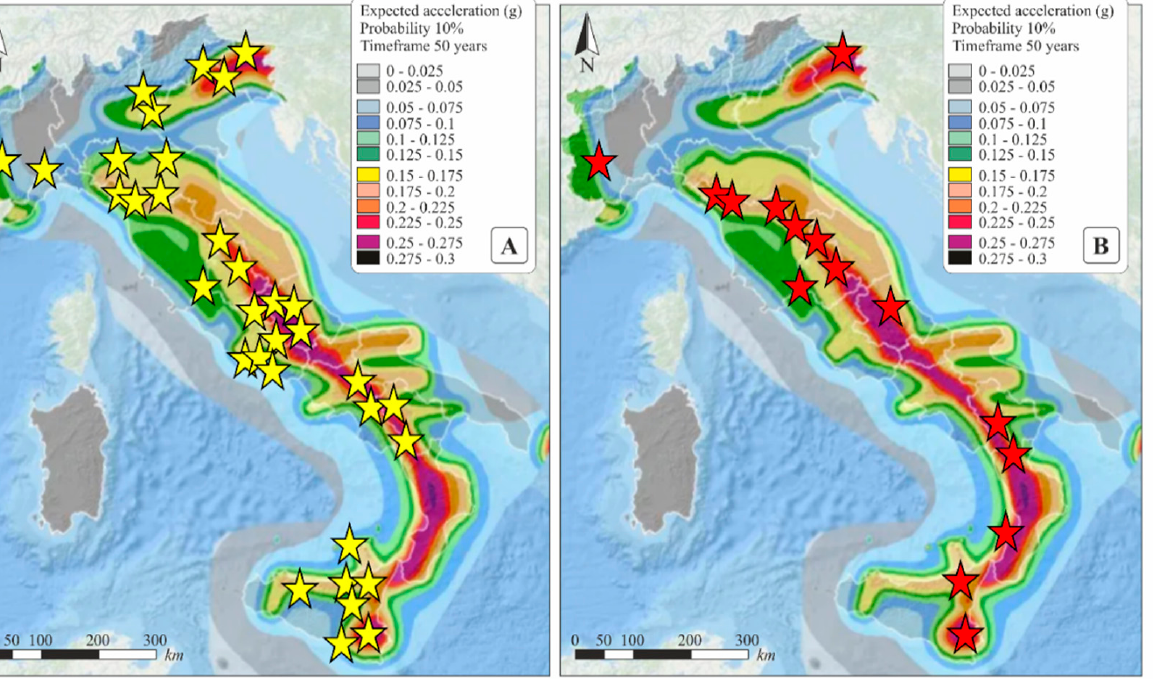
Figure 1. Seismic risk map for Italy (modified after http://esse1-gis.mi.ingv.it/), along with the location of the monitoring sites in Italy where tectonic-related signals have been recorded during the last four decades. ( A ) Yellow stars: sites currently not monitored; ( B ) red stars: sites currently mon- itored.